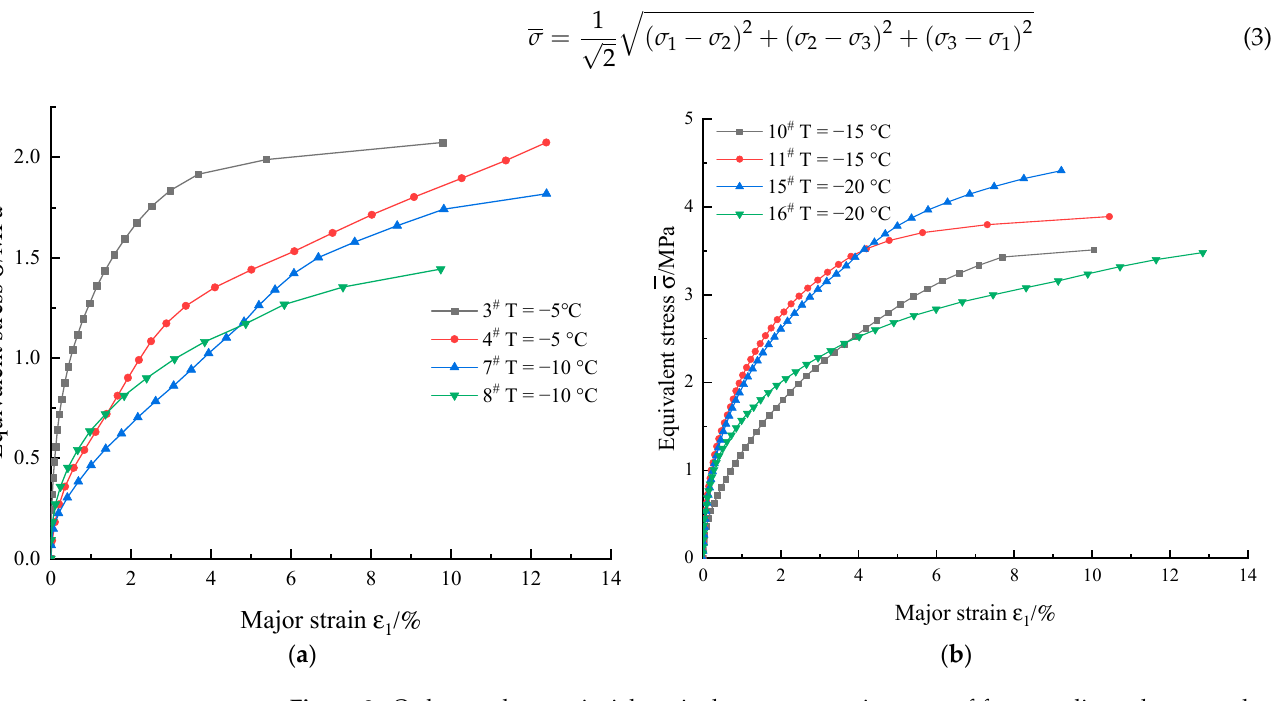
Figure 3. Orthogonal true triaxial equivalent stress–strain curve of frozen saline calcareous clay. ( a )